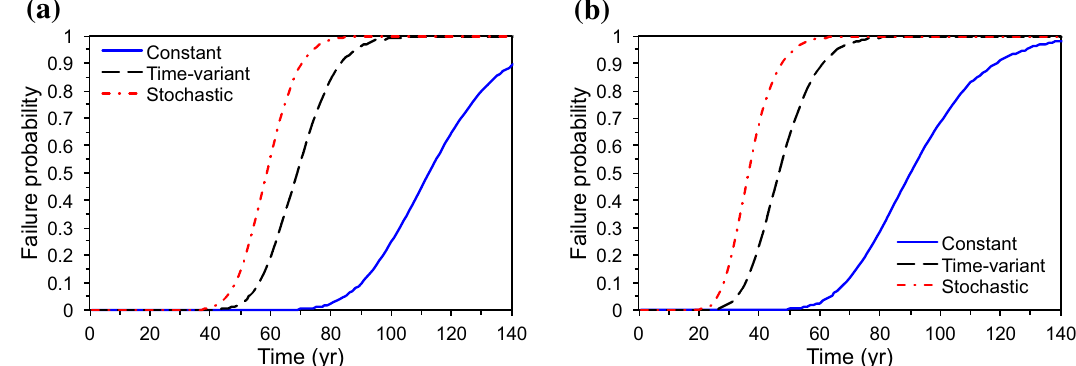
Fig. 4 Influence of the type of weather model on the failure probability for the oceanic environment and two traffic frequencies: a f = 50/day, b f = 2000/day.